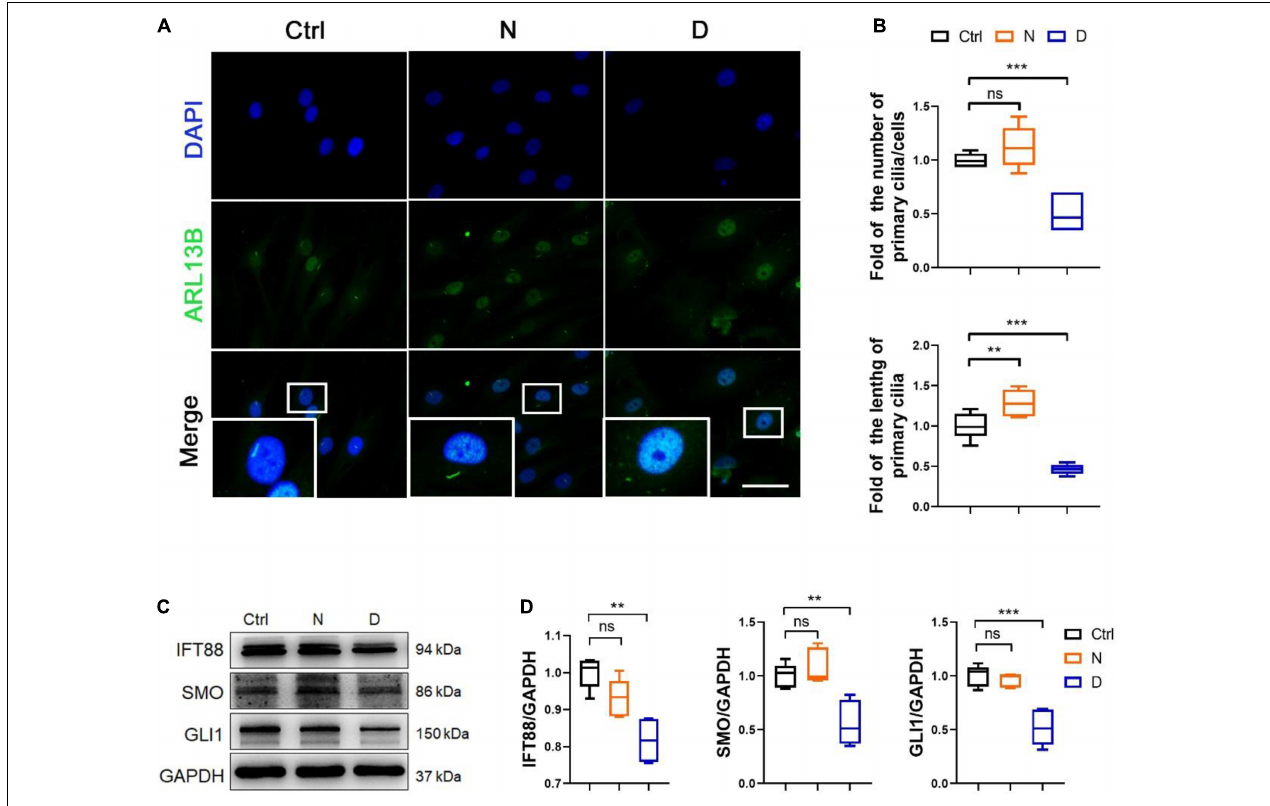
FIGURE 4 | The inhibition of microtubule (MT) stabilization in the formation of primary cilia in SMSCs. (A) Immunofluorescence staining of ARL13B (for representing primary cilia) in synovial mesenchymal stem cells (SMSCs) treated with nocodazole (N) and docetaxel (D) in chondrogenic medium (CM) for 1 week. (B) Quantification of (A) for the number and length of primary cilia in SMSCs. n = 6. (C) Western blot analysis of IFT88, SMO, and GLI1 in SMSC. (D) Quantification of the data of (C) . n = 5. Data are represented as the mean ± SEM. ** p < 0.01, *** p < 0.001.